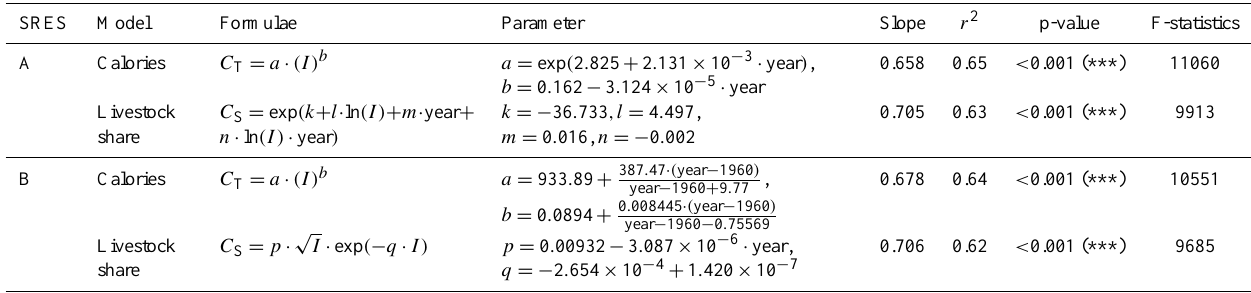
Table A8. Regression models for total calories C T in kcal and the share of livestock calories in total demand C S , depending on income I in 2005 US Dollar in market exchange